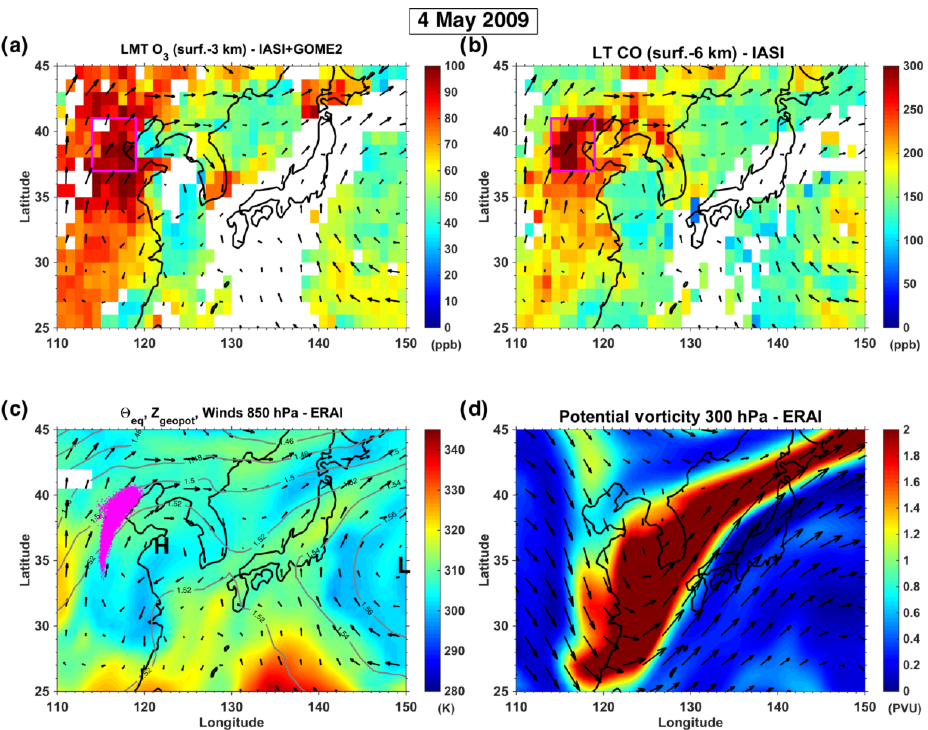
Figure 7. Same as Fig. 5 but for 4 May